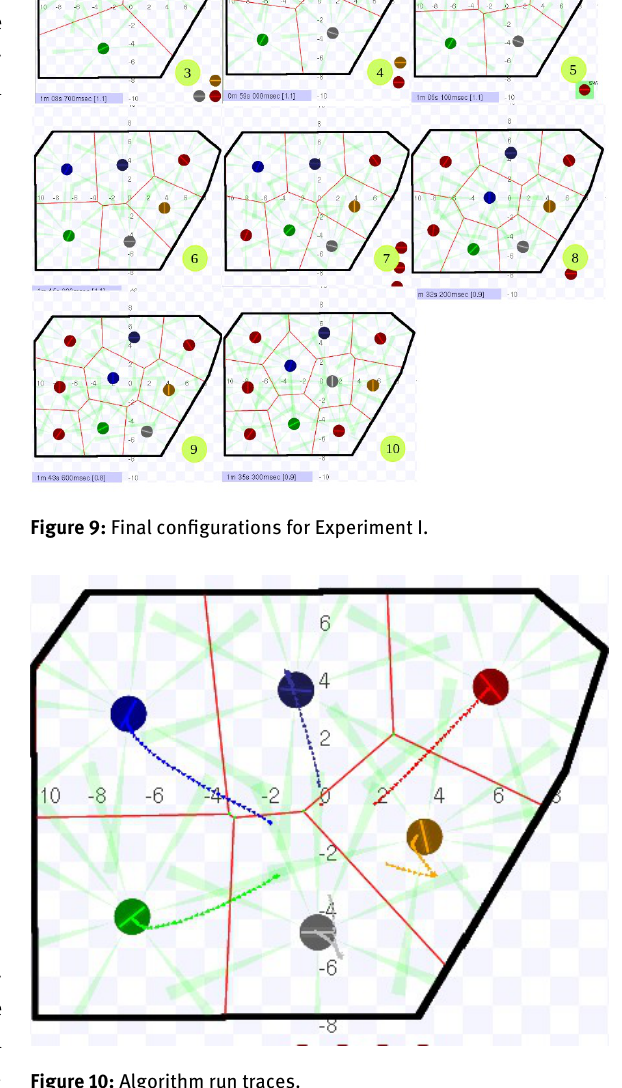
Figure 10: Algorithm run